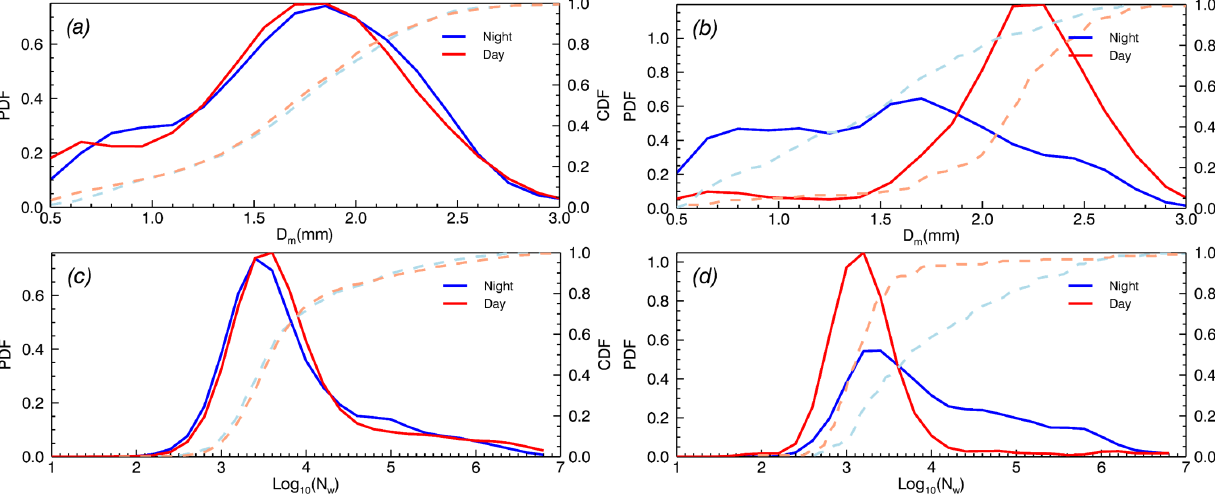
Figure 13. As in Fig. 12 but for convective rainfall